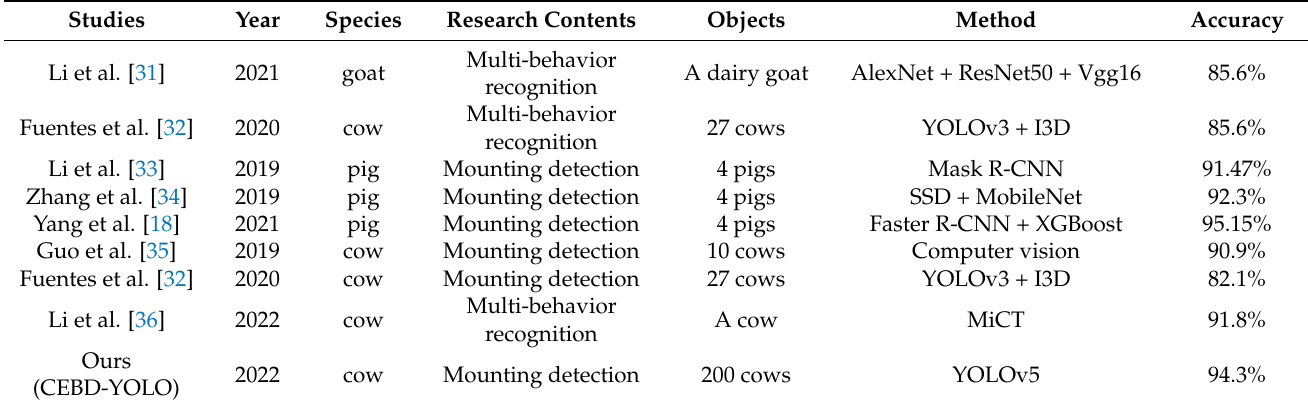
Table 8. Comparison of different livestock behavior detection